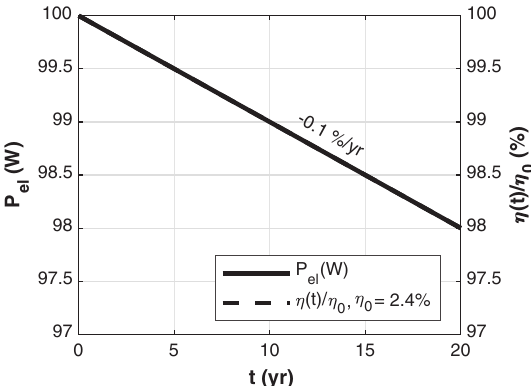
Figure 3. Power and efficiency decay with time of a 100 W TEG.